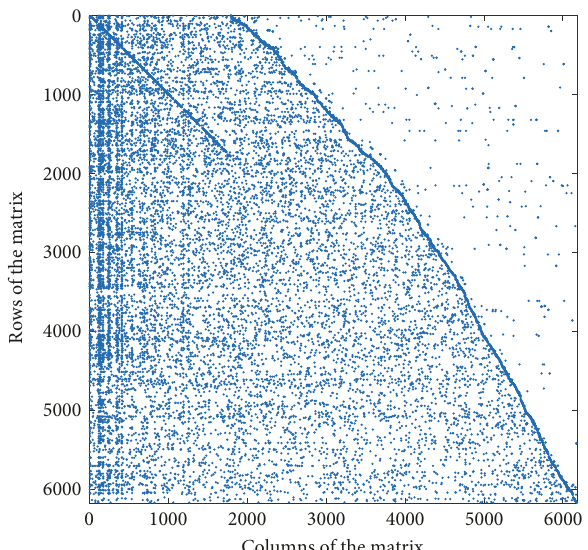
Figure 16: Nonzero elements of adjacency matrix for Gnutella peer to peer network after removing sources. The number of nonzero elements of adjacency matrix is 19744.